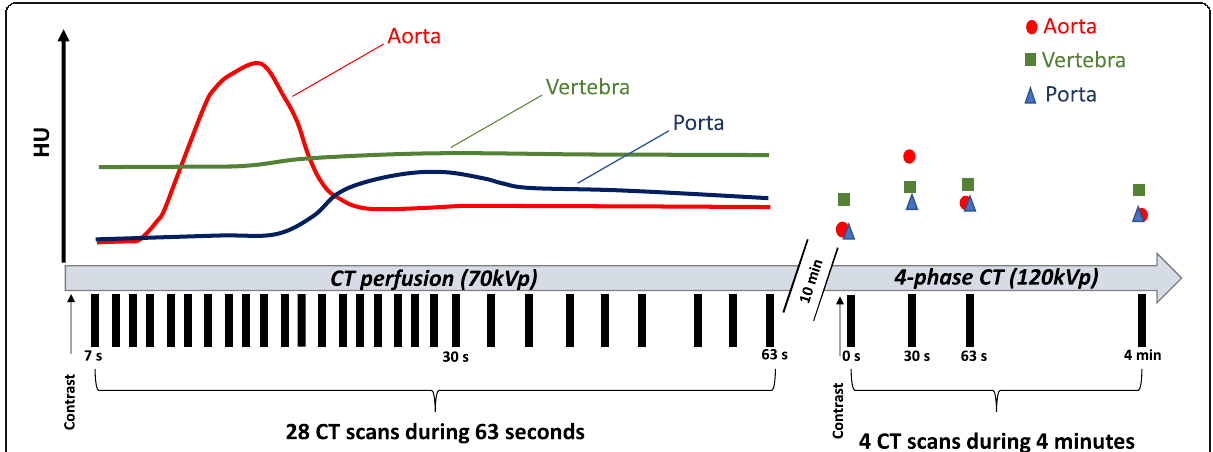
Fig. 1 Study protocol which included: (1) a computed tomography (CT) perfusion imaging examination (28 scans performed over 63 s); (2) a 10-min break and finally; (3) a conventional 4-phase CT examination (four scans performed over 4 min). Contrast behaviour over time in three organs, i.e. , aorta (red), vertebra (green), and portal vein (blue) are schematically visualised. Black boxes on x -axis: time point of each CT scan. The HU in the aorta and portal vein were measured approximately at the height of vertebra L1. The time curves of the aorta and portal vein are given as a reference for the contrast media behaviour in different blood phases. HU Hounsfield